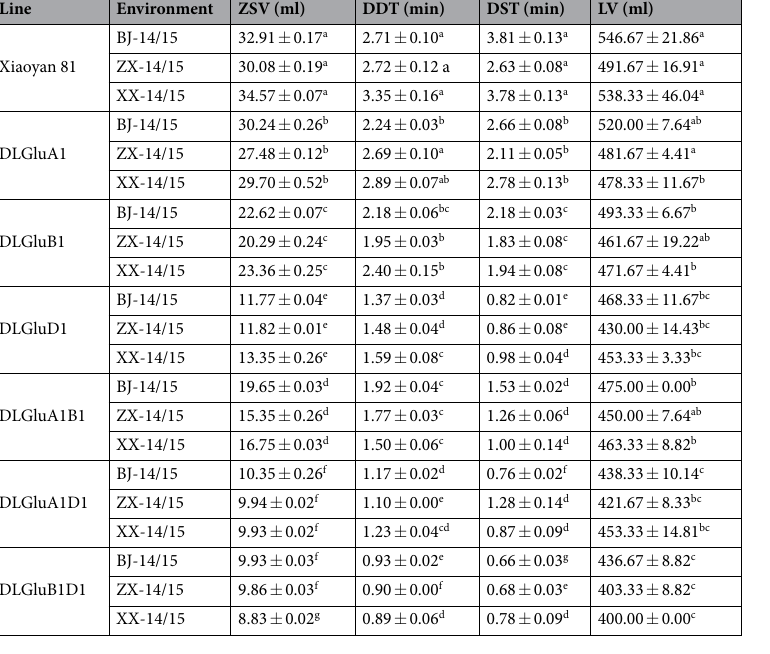
Table 2. Comparison of ZSV, two Farinograph parameters (DDT and DST) and loaf volume (LV) among Xiaoyan 81 and six deletion lines cultivated in 2014/2015 a . a Each value is the mean ± SE of three separate tests. Different letters after the means indicate statistically significant difference ( P < 0.05). BJ, Beijing; DDT, dough development time; DST, dough stability time; LV, loaf volume; XX, Xinxiang; ZSV, Zeleny sedimentation volume; ZX,